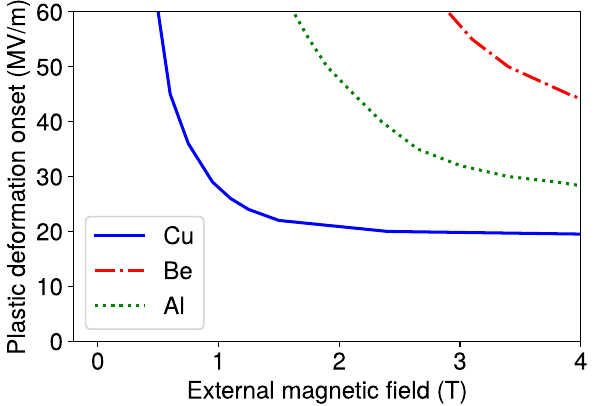
FIG. 3. Predicted cavity gradients vs external, solenoidal magnetic field strength, based on the beamlet pulsed heating model. Beryllium cavity walls should be less susceptible to fatigue from beamlet pulsed heating and should therefore operate at higher gradients relative to